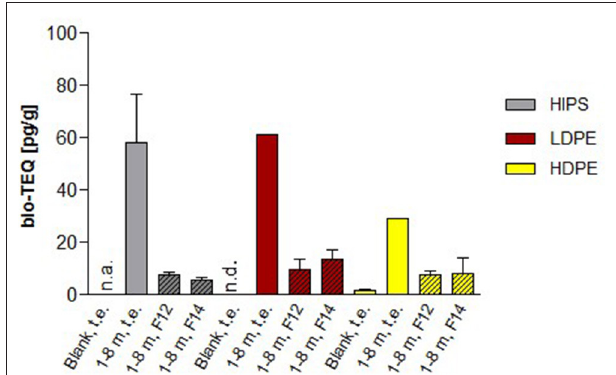
FIGURE 2 | Overview of calculated bio-TEQs (EC 10 ) in pg/g in total and fractionated extracts of pooled plastics. n.a. = not analyzed; n.d. = AhR-mediated potency less than LOD in the assay; t.e. = total extract,